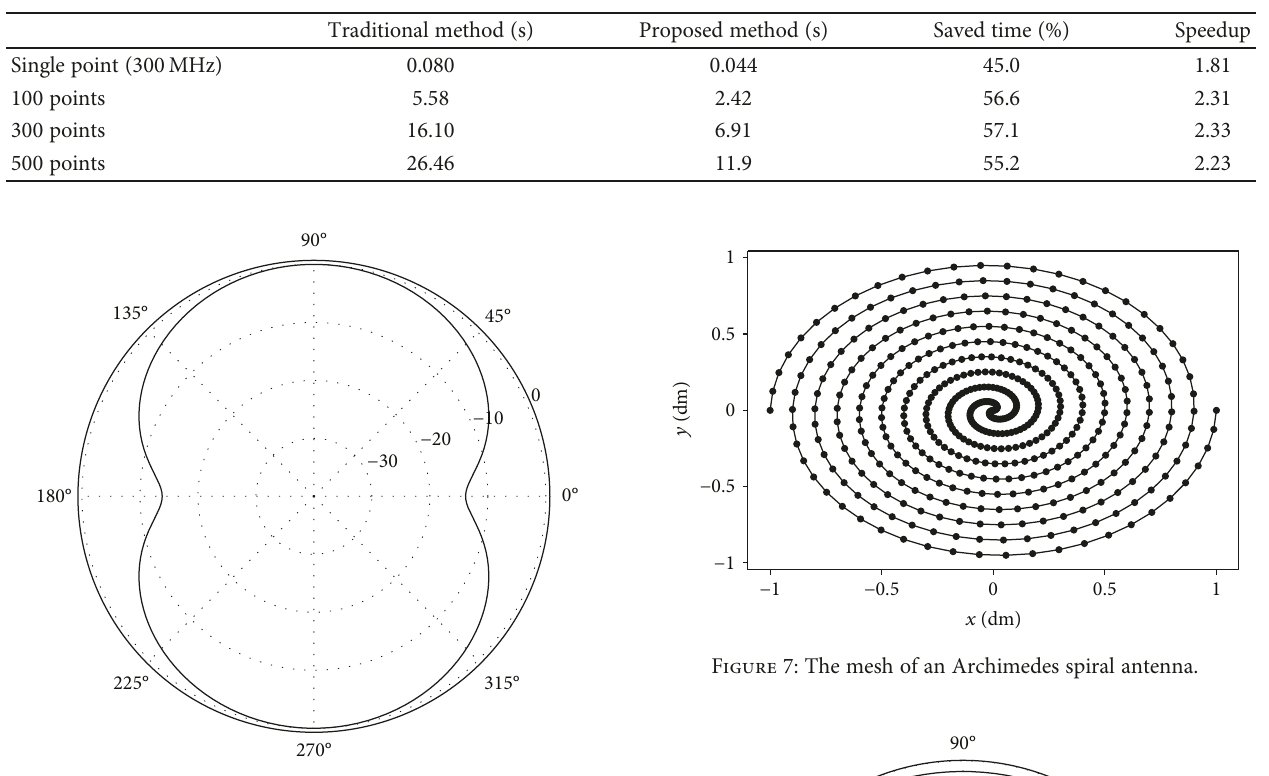
Figure 5: Radiation pattern on E-plane (4.8 MHz).